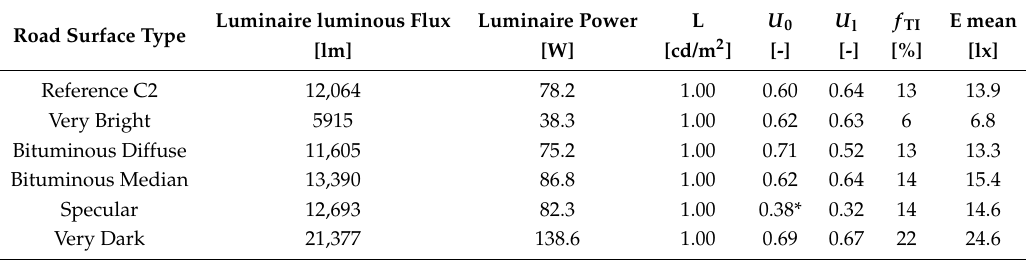
Table 10. Road lighting with rescaled values to fulfil the normative requirement on luminance for Case